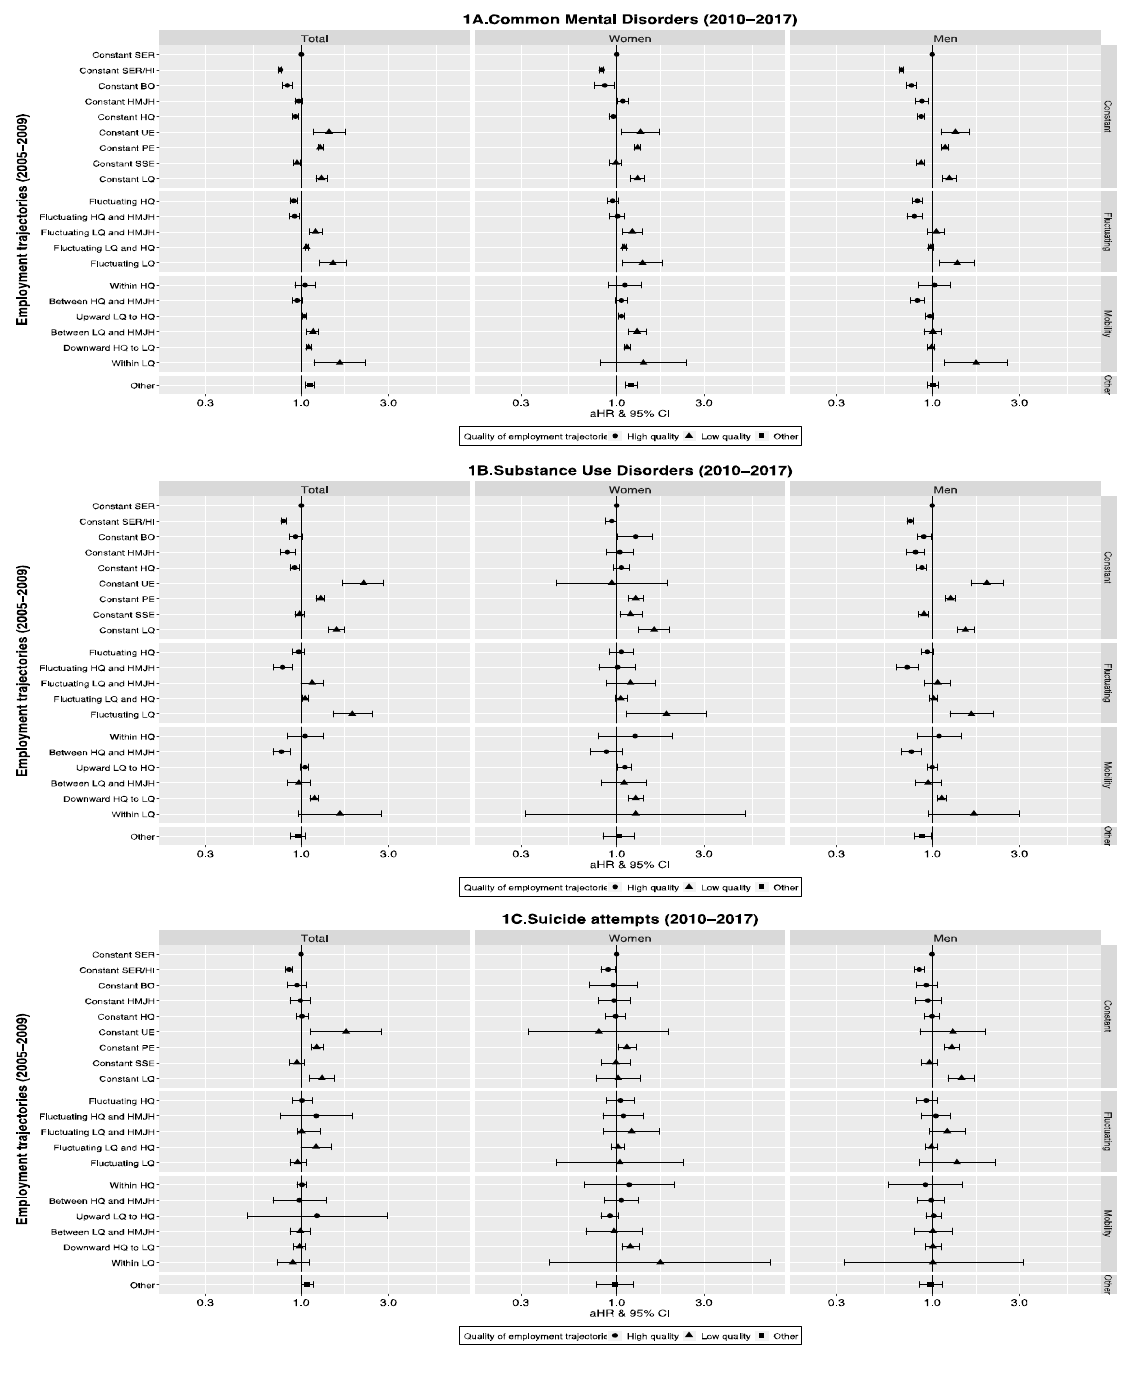
Figure 1a–c . Adjusted hazard ratios (aHR) and their 95% confidence intervals (95%CI) of common mental disorders, substance use disorders and suicide attempts (2010-2017) according to employment trajectories (2005-2009). aHR adjusted for sex, age in 2005, level of education in 2005, marital status in 2005, country of birth, any mental disorder before 2003, parental mental disorders, parental socioeconomic position during childhood. Total (N=2 743 764), men (N=1 467 914), women (N=1 275 850). [UE=unemployment; PER=precarious employment relationship; SSE=solo self-employment; HMJH=hybrid multiple job-holding; BO= business ownership; SER= standard employment relationship; SER/HI=standard employment relationship with high income; LQ=low quality; HQ=high